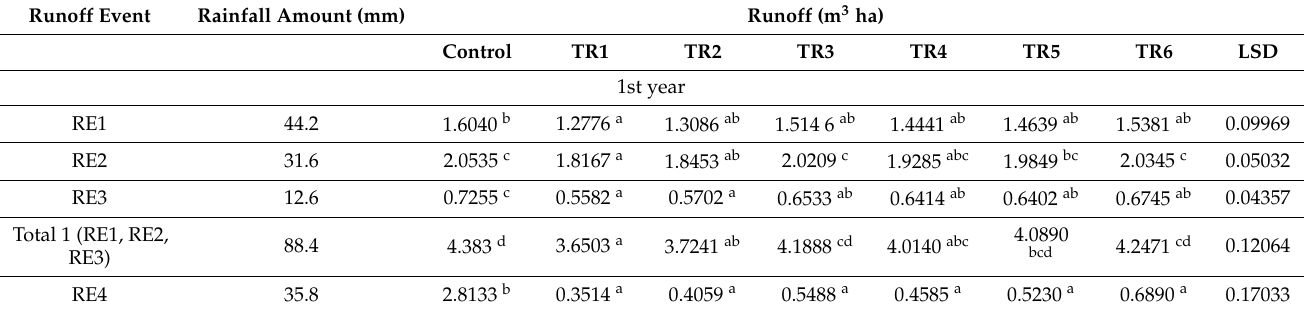
Table 4. Mean values of runoff volumes (m 3 ha − 1 ) in the seven treatments of the two cultivation